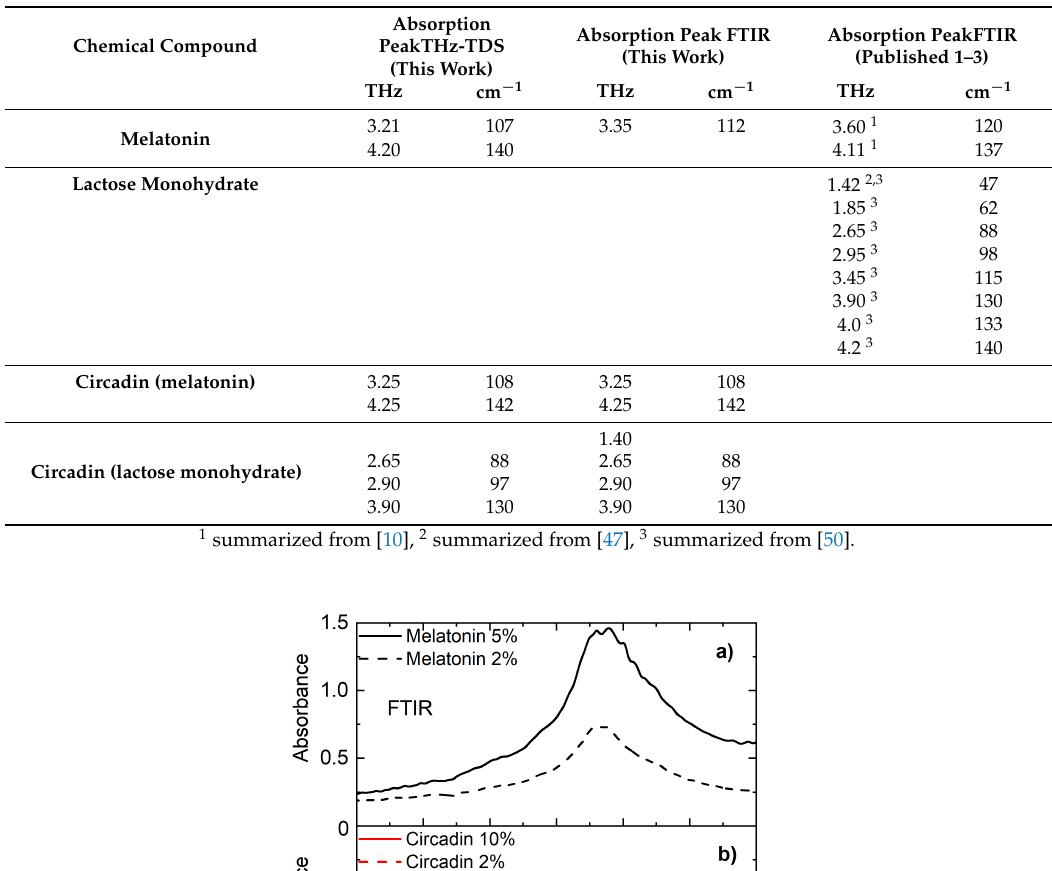
Table 2. Absorption peaks for melatonin and lactose monohydrate in frequency range 1.0–4.5 THz obtained by THz-TDS and FTIR in this research and summarized from other sources.